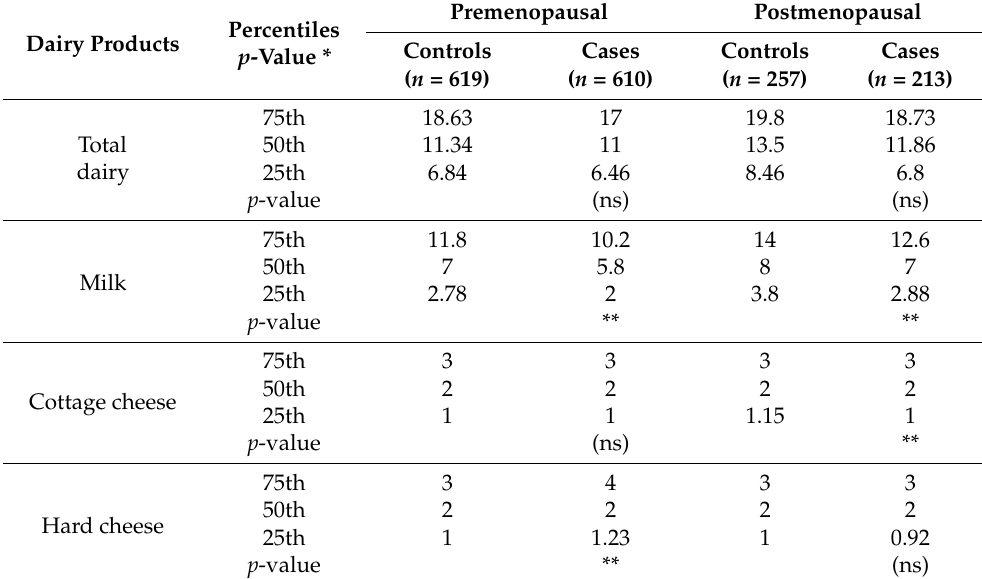
Table 2. Percentile distribution, for dairy products consumption (servings/week), for premenopausal and postmenopausal